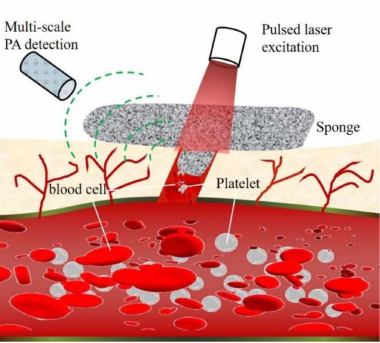
Figure 1. Schematic of multi-scale photoacoustic assessment of Chi-GO hemostatic